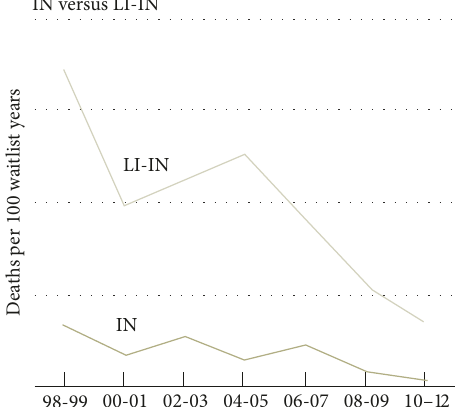
Figure 2: Waitlist mortality among patients listed for isolated intestinal transplantation and combined liver-intestine transplanta- tion. Notes . (1) From SRTR report 2012 [19]. (2) LI-IN: combined liver-intestine transplantation; IN: isolated intestinal transplanta-